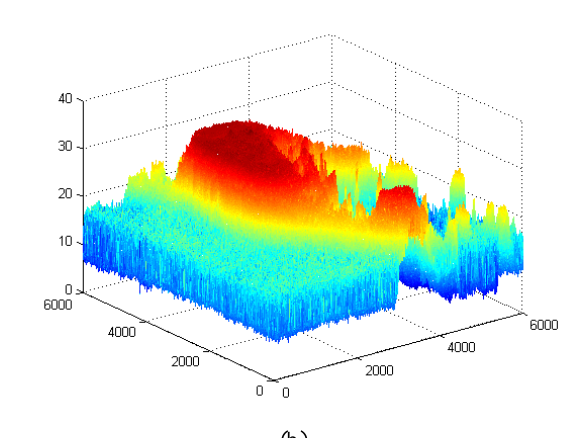
Figure 6. The bathymetry estimation in 2D and